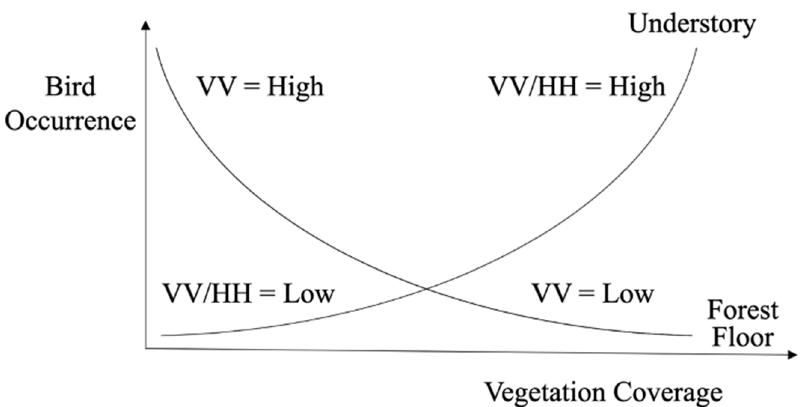
Figure 7. Schematic diagram of the inverse relationship between understory and forest floor vege- tation. Higher understory coverage is represented by increased VV/HH, which positively relates to bird occurrence rate. On the contrary, lower forest floor coverage is presented by increased VV sig- nals which also positively relate to bird occurrence.